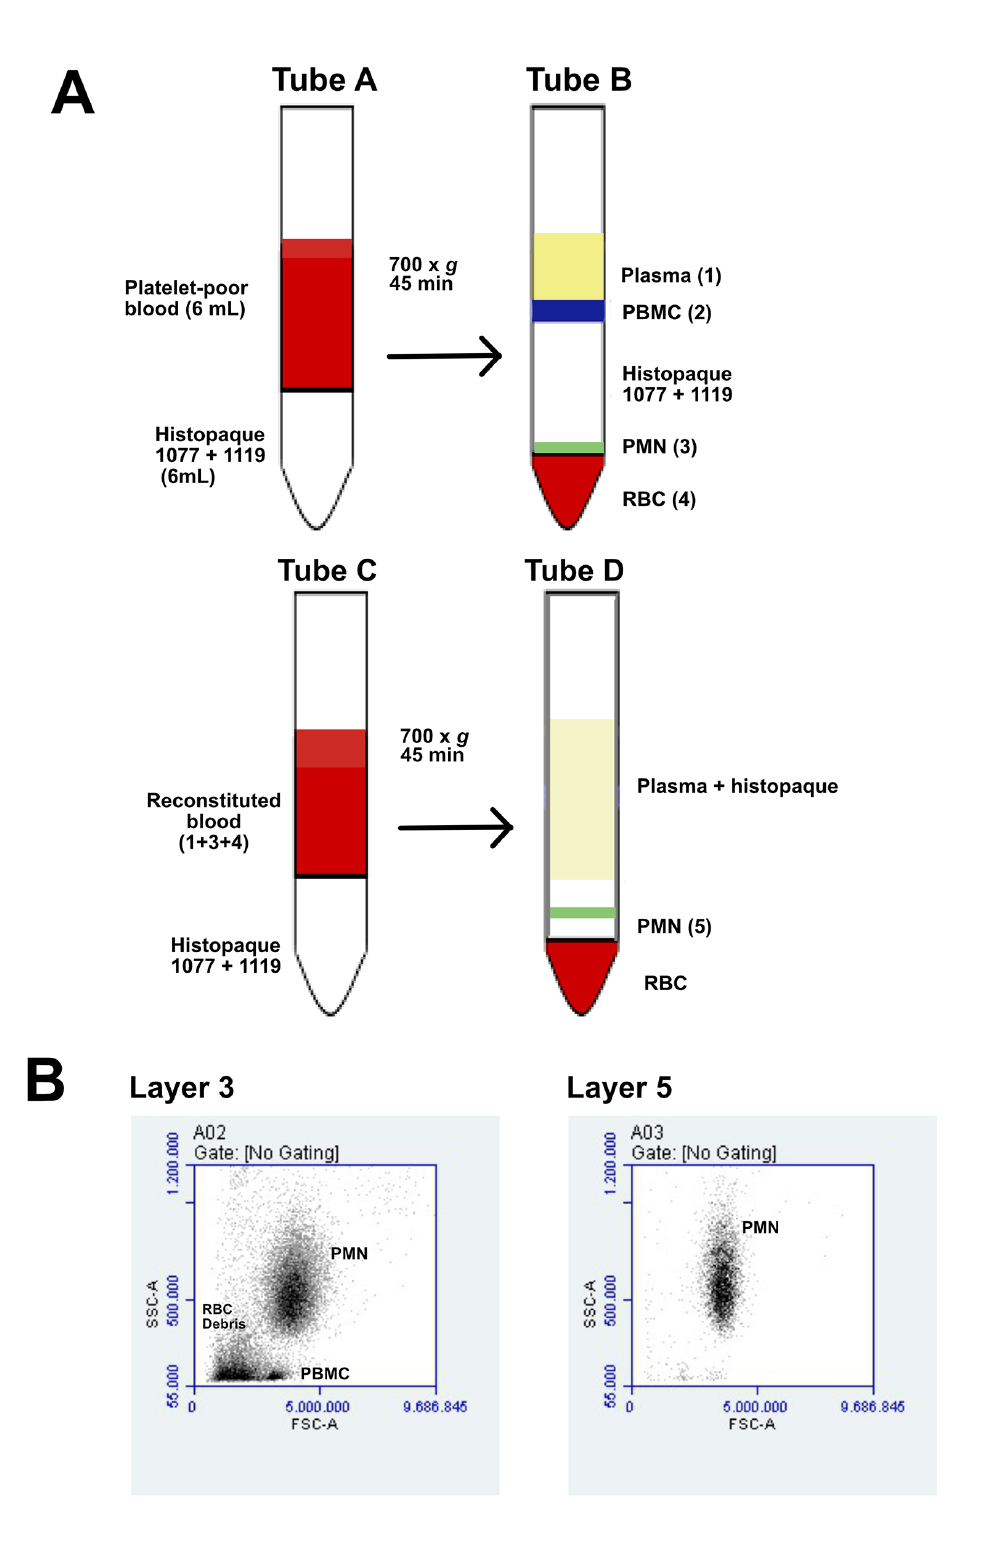
Figure 1. Isolation of neutrophils from human peripheral blood. Whole blood underwent a prior centrifugation step to isolate plasma and remove platelets. (A) Platelet-poor blood was used for the first fractionation step using Histopaque ® 1077 and 1119, resulting in four distinct layers: plasma, peripheral blood mononuclear cells (PBMC), polymorphonuclear neutrophils (PMN), and red blood cells (RBC). Plasma, PMN and RBC were reunited for a second isolation to allow us to obtain a PMN-enriched fraction. (B) Flow cytometry analysis of various fractions. Dot plot showing the mixture of PMN, RBC and PBMC in layer 3, and the high concentration of PMN (layer